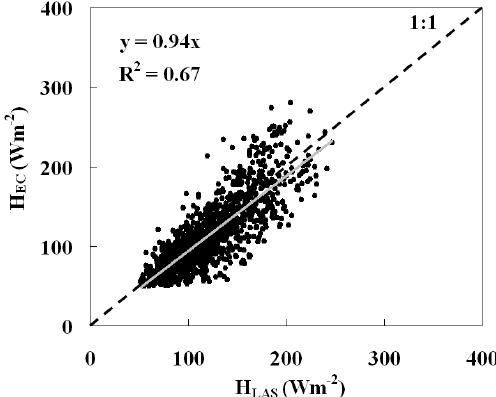
Fig.9. Comparison of H LAS and H EC at AR when the H LAS and H EC >50 W m -2 and EBR>0.75 (11 March to 31 October 2008, and 1 January to 30 June 2009, 30-min averaging time) Fig. 9. Comparison of H LAS and H EC at AR when the H LAS and H EC > 50Wm − 2 and EBR > 0.75 (11 March to 31 October 2008, and 1 January to 30 June 2009,